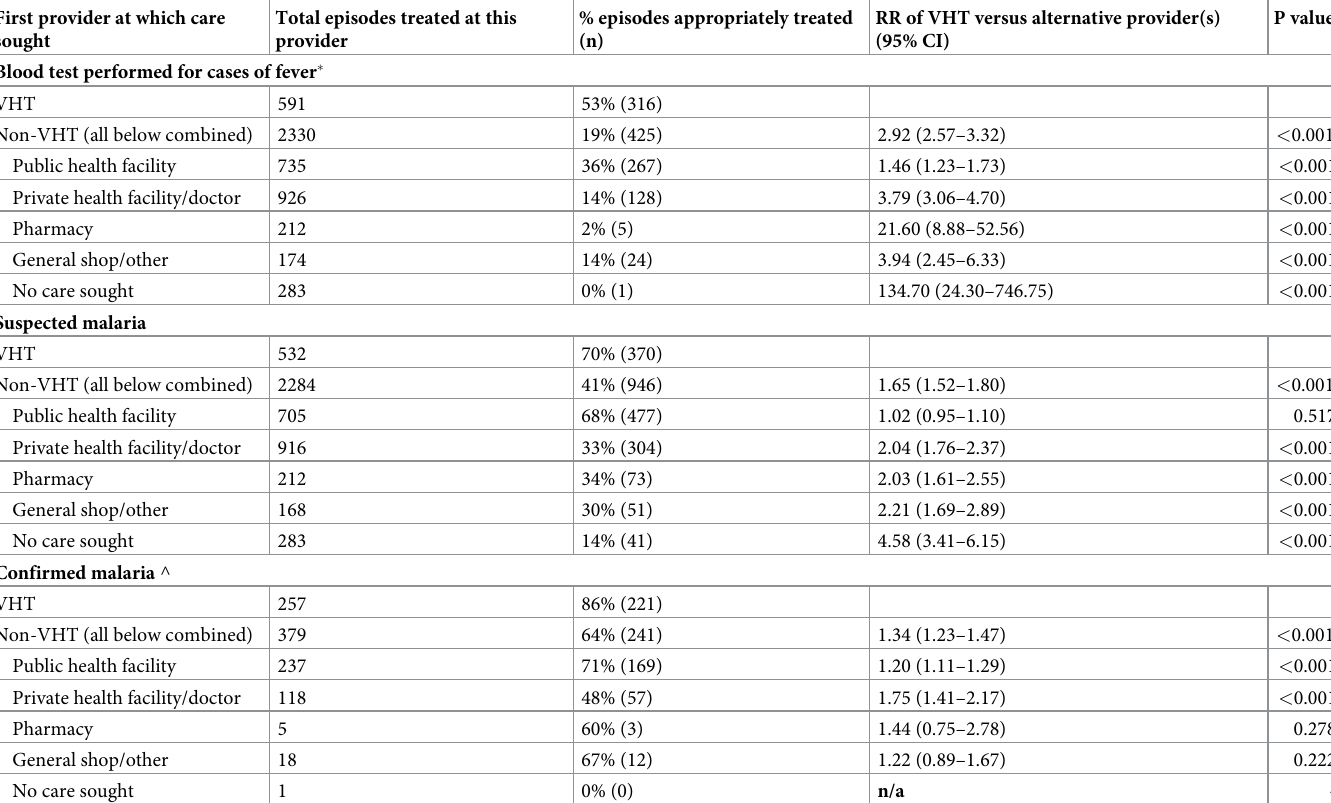
Table 6. Blood test performance rates and appropriate treatment of children with suspected or confirmed malaria by first provider where care was sought. Signifi- cance tests compare appropriate treatment rate at the VHT (‘exposure group’) versus other provider types (‘null group’) in